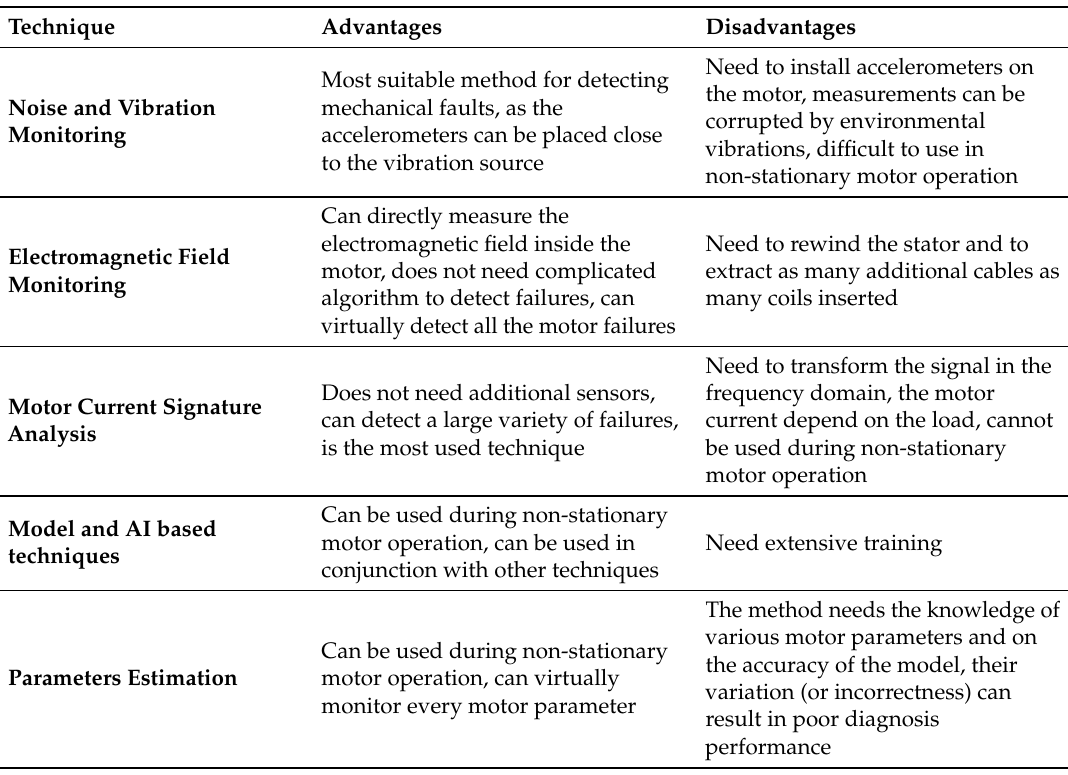
Table 3. Techniques